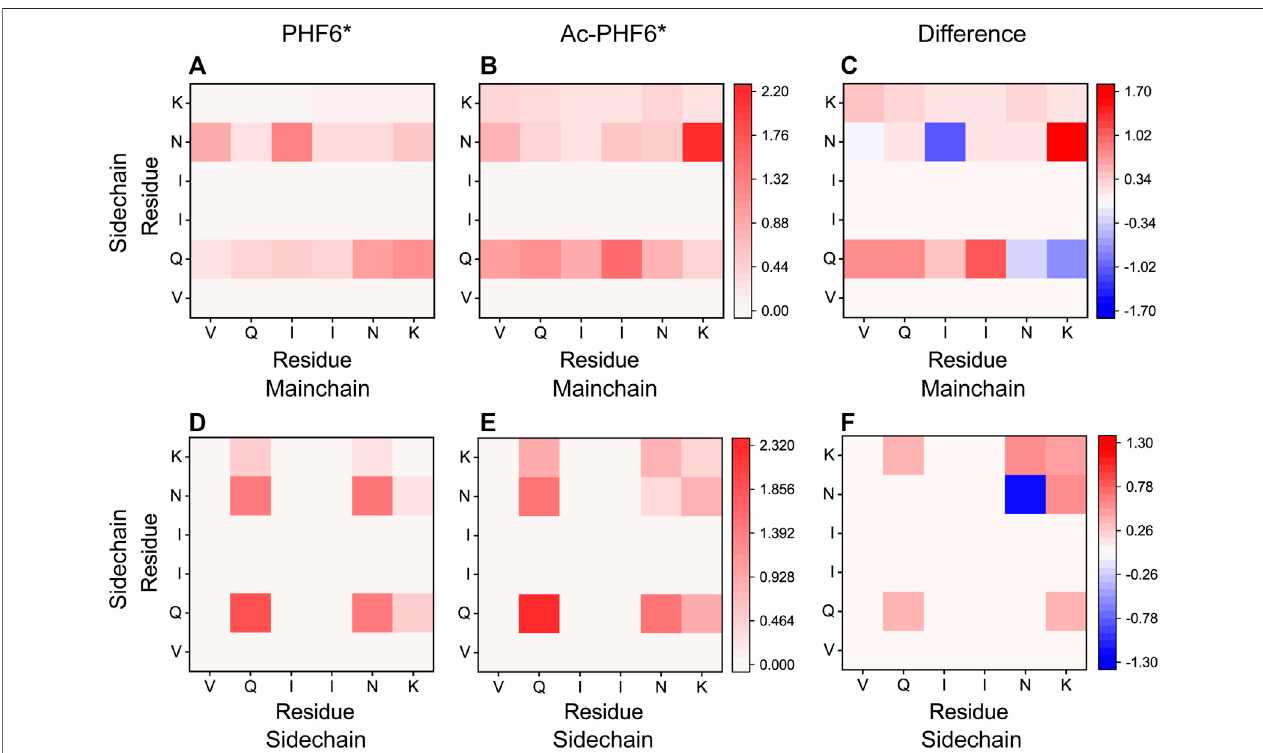
FIGURE 6 | Analyses of K280 acetylation on the H-bond interactions: formation maps of MC-SC and SC-SC H-bonds in the PHF6* (A,D) and Ac-PHF6* (B,E) systems.TheH-bondmapforthedifferencebetweentwosystemsisgivenin (C,F) .ThedifferencesarecalculatedusingtheH-bondnumberofresiduepairsinAc-PHF6* system minus those in PHF6* system. The number of H-bond is averaged over twelve peptide chains.